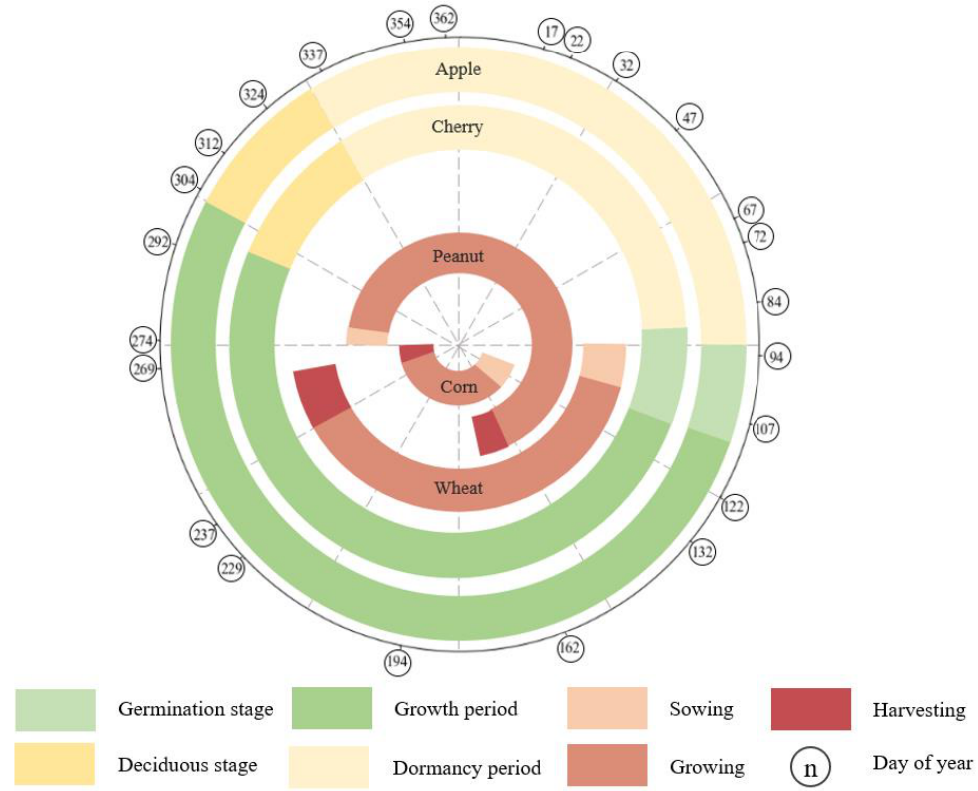
Figure 2. Crop phenological information and image acquisition time.